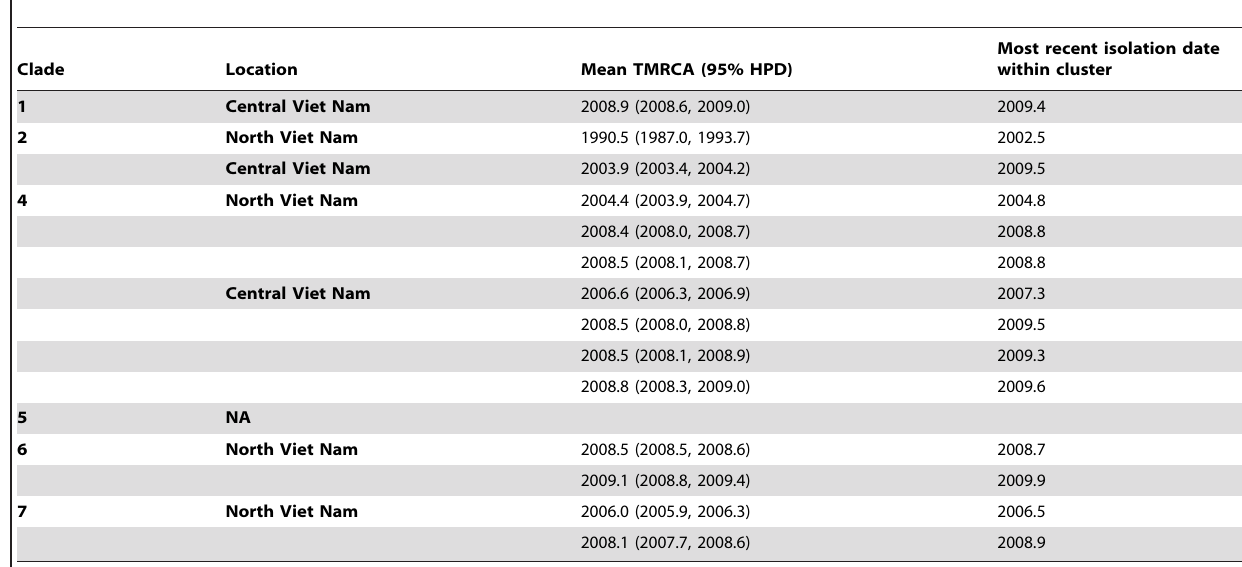
Table 2. Estimates of the Time to the Most Recent Common Ancestor (TMRCA) and the time of the last viral isolate of clusters circulating in central and northern Viet Nam.